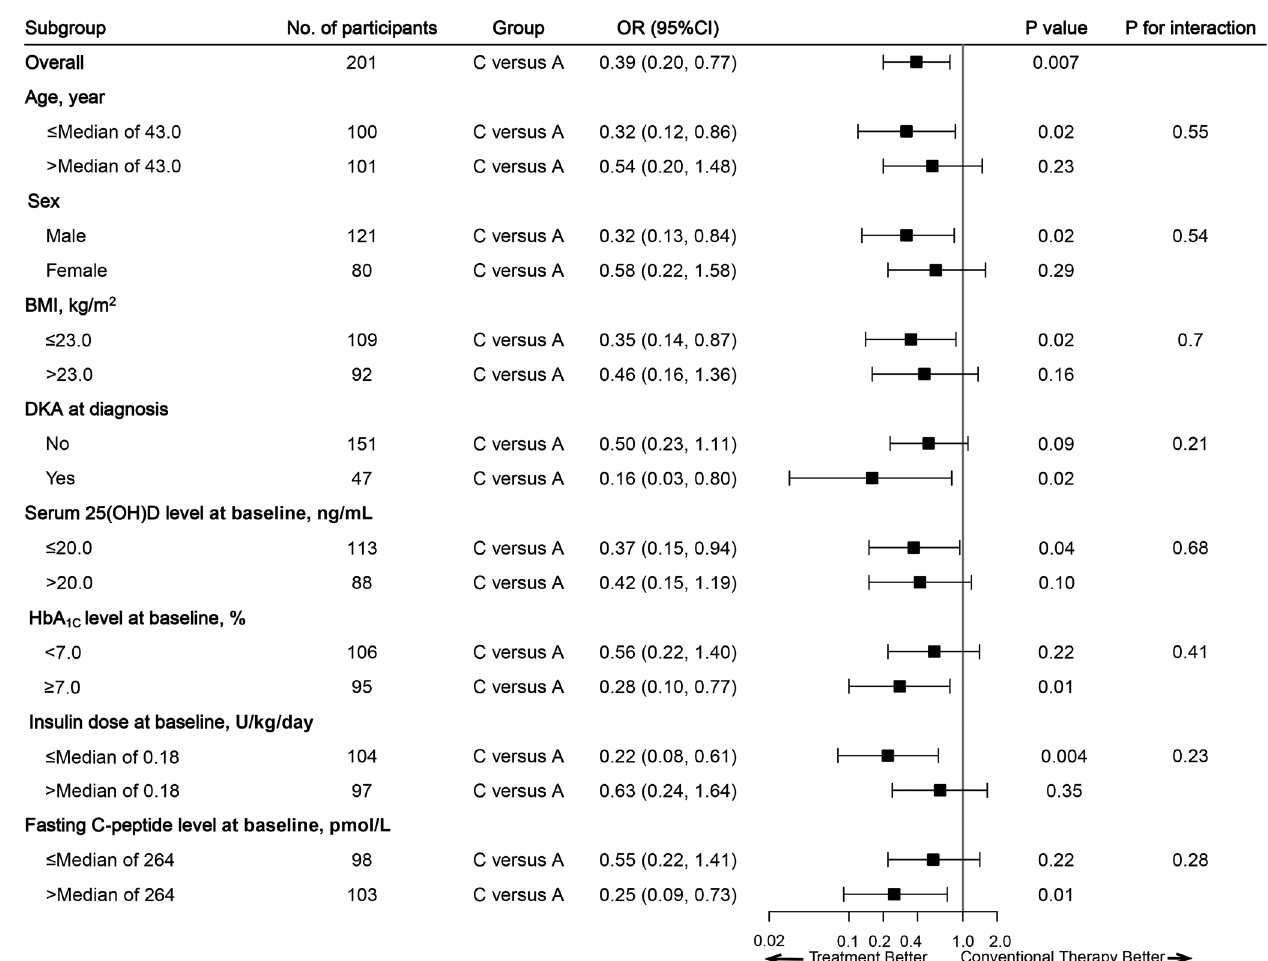
saxagliptin plus vitamin D group as compared with the conventional therapy group, strati fi ed by baseline factors (two categories of each). The logistic regression model was adjusted for age at recruitment, sex, baseline C-peptide (log[AUC + 1]), baseline vitamin D concentration and DKA at diagnosis. Group A: conventional therapy, Group C: saxagliptin plus vitamin D; AUC area under the curve, BMI body mass index, DKA diabetic